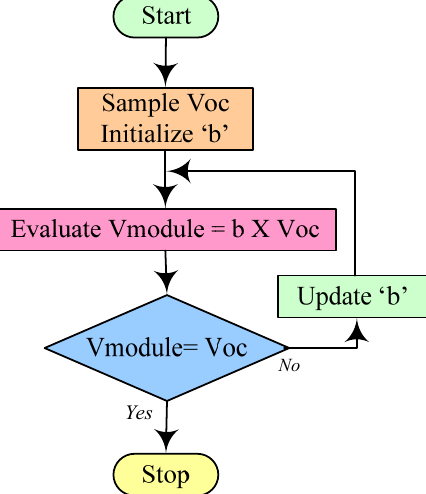
Figure 10. FOCV-based MPPT technique [29].